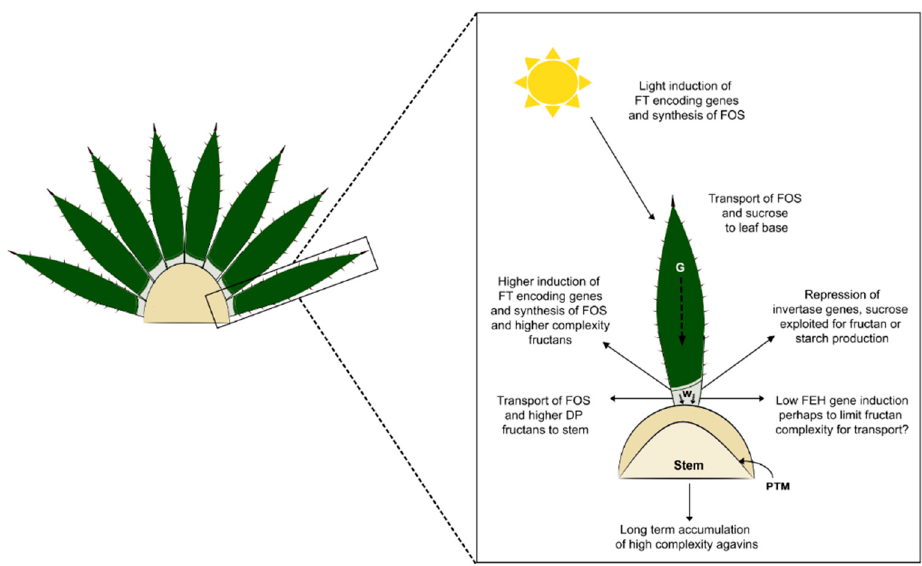
Figure 9. Model for the integration of light and leaf specific regulation of PGHF32 members into overall carbohydrate metabolism in A. tequilana . FT, fructosyltransferases, FOS, fructooligosaccharide, DP, degree of polymerization, G, green leaf tissue, W, white leaf tissue, PTM, primary thickening meristem.